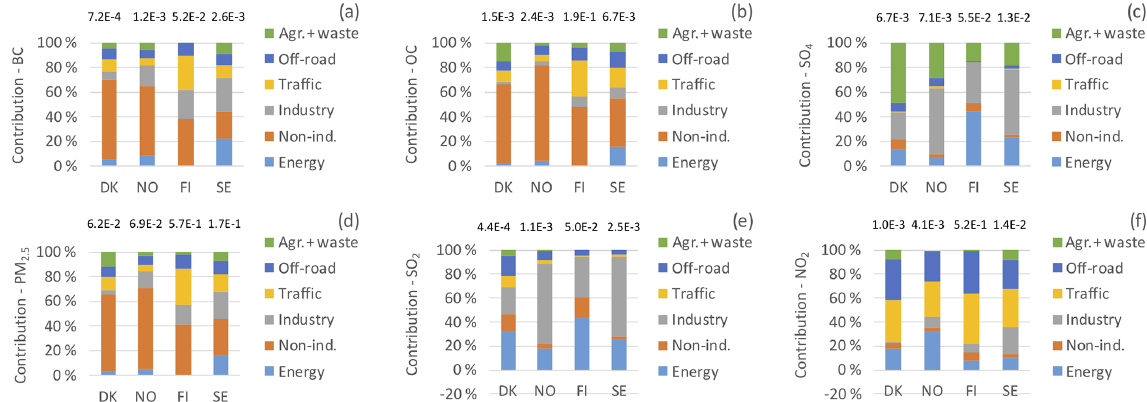
Figure 8. Population-weighted sectoral contributions of Finnish emissions on surface (a) BC, (b) OC, (c) SO 4 , (d) PM 2 . 5 , (e) SO 2 and (f) NO 2 over the Nordic countries. The labels above the bars show the absolute total contribution in µgm − 3 from all the sectors in Finland.